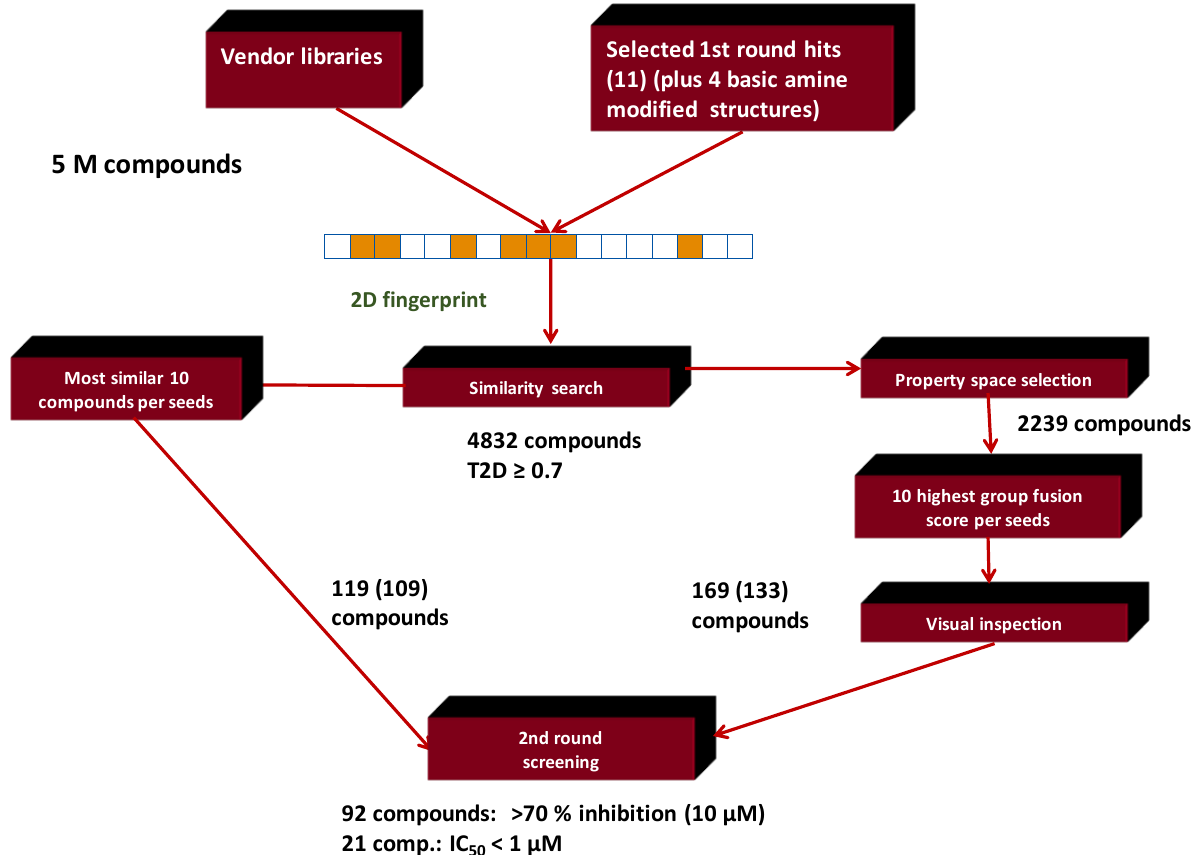
Figure 17. Combination of 2D similarity selection with group fusion; MCHR1.